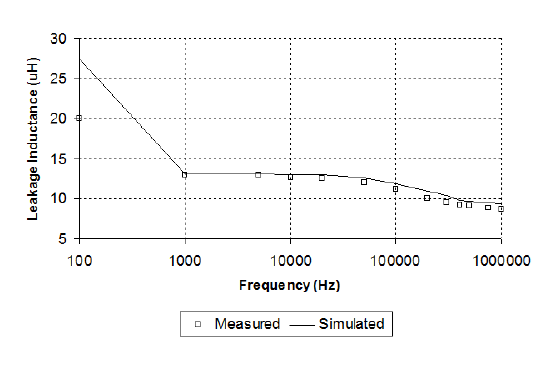
Figure 9: UOM2T Model Leakage Inductance Calculation